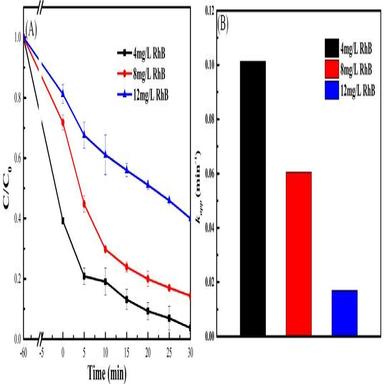
Effect of initial pollutant concentration on the sonocatalytic degradation of RhB (A) and the corresponding Kapp values (B).